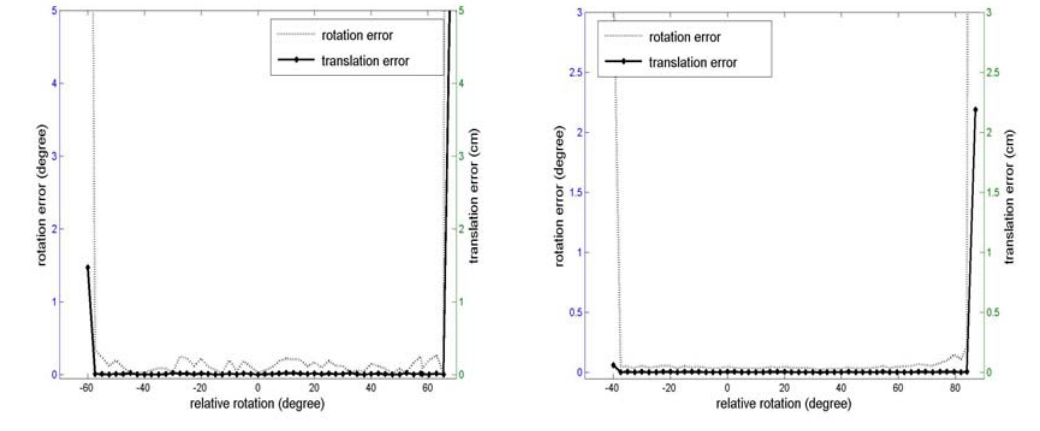
Figure 9. Registration errors of data from the Stanford 3D repository using the GP-ICP. (a) and (b) are the errors in the estimated transformation parameters by the GP-ICP for the Stanford bunny and the happy Buddha, respectively, without a relative translation. (c) and (d) are the same values when a point cloud is translated to translation 1 of the